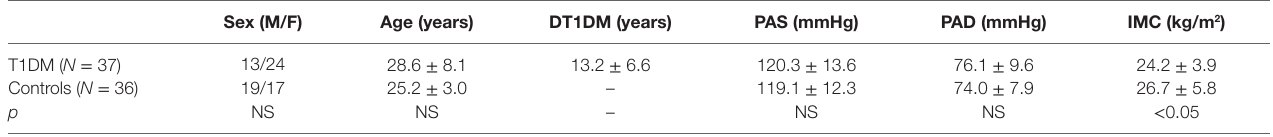
Table 1 | clinical characteristics of T1DM and controls.